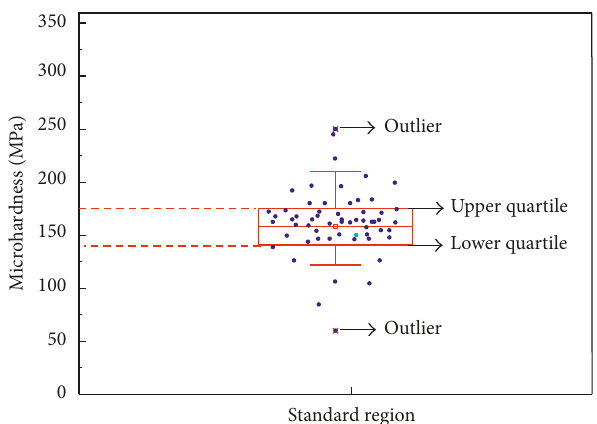
Figure 4: Schematic of the standard area box diagram method.